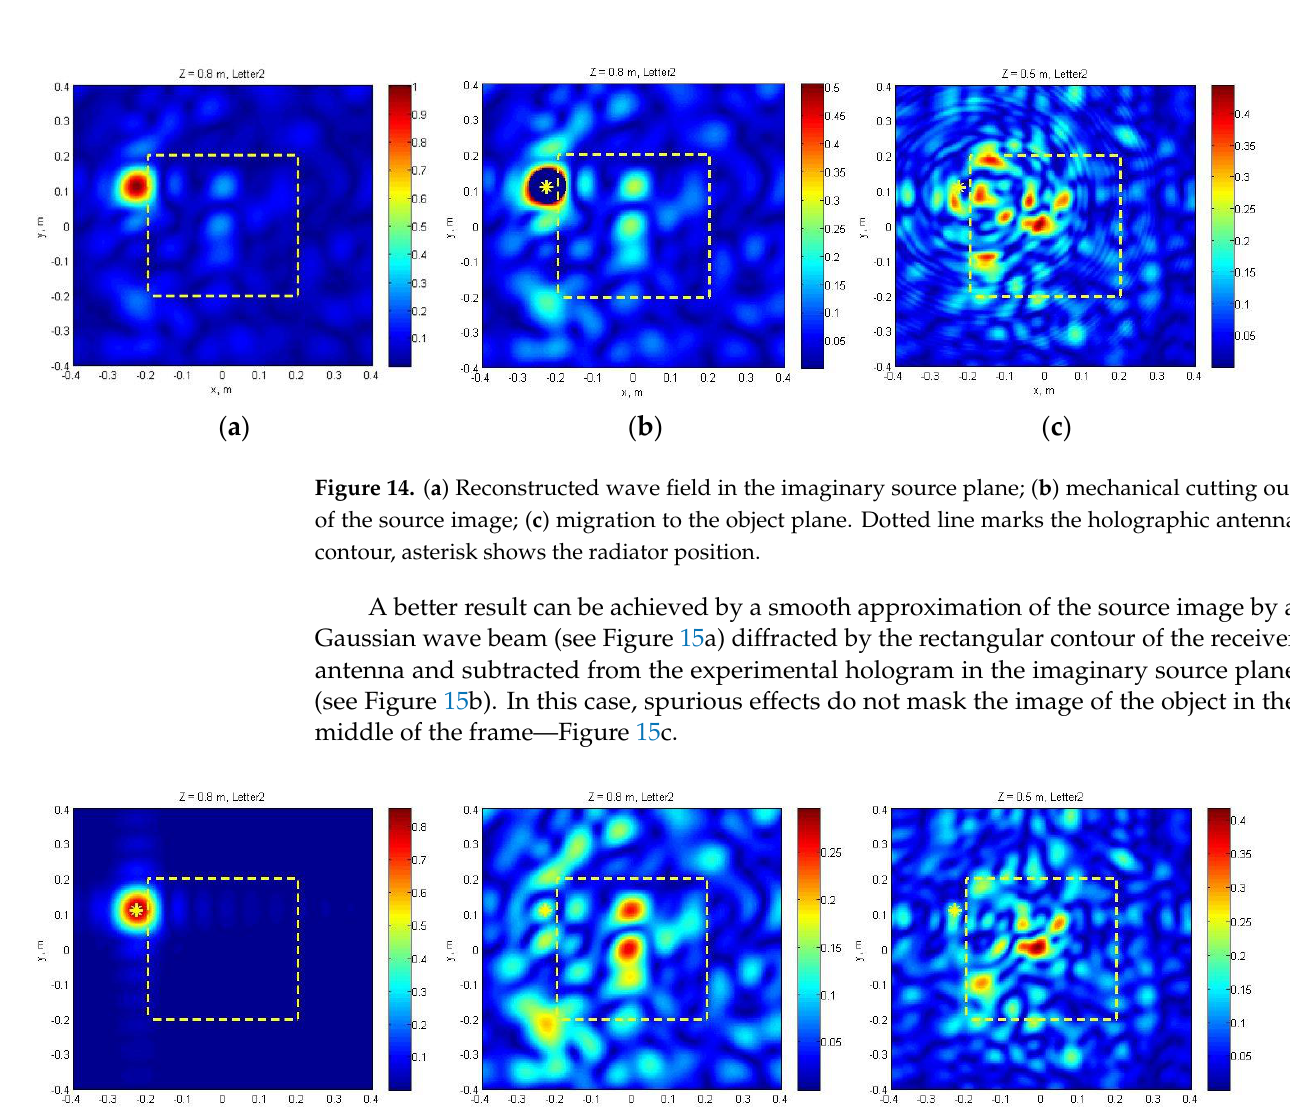
(b) Figure 13. Wave scattered by a subsurface object is masked by specular reflection from the medium outer boundary ( a ); wave front conversion localizes the imaginary source ( b ). Notations: radiator, R; object, O; holographic antenna, A; mirror source image, M. The following series of experimental color plots illustrates the possibility of visualizing the subsurface object. Figure 14a shows the distribution of the wavefield